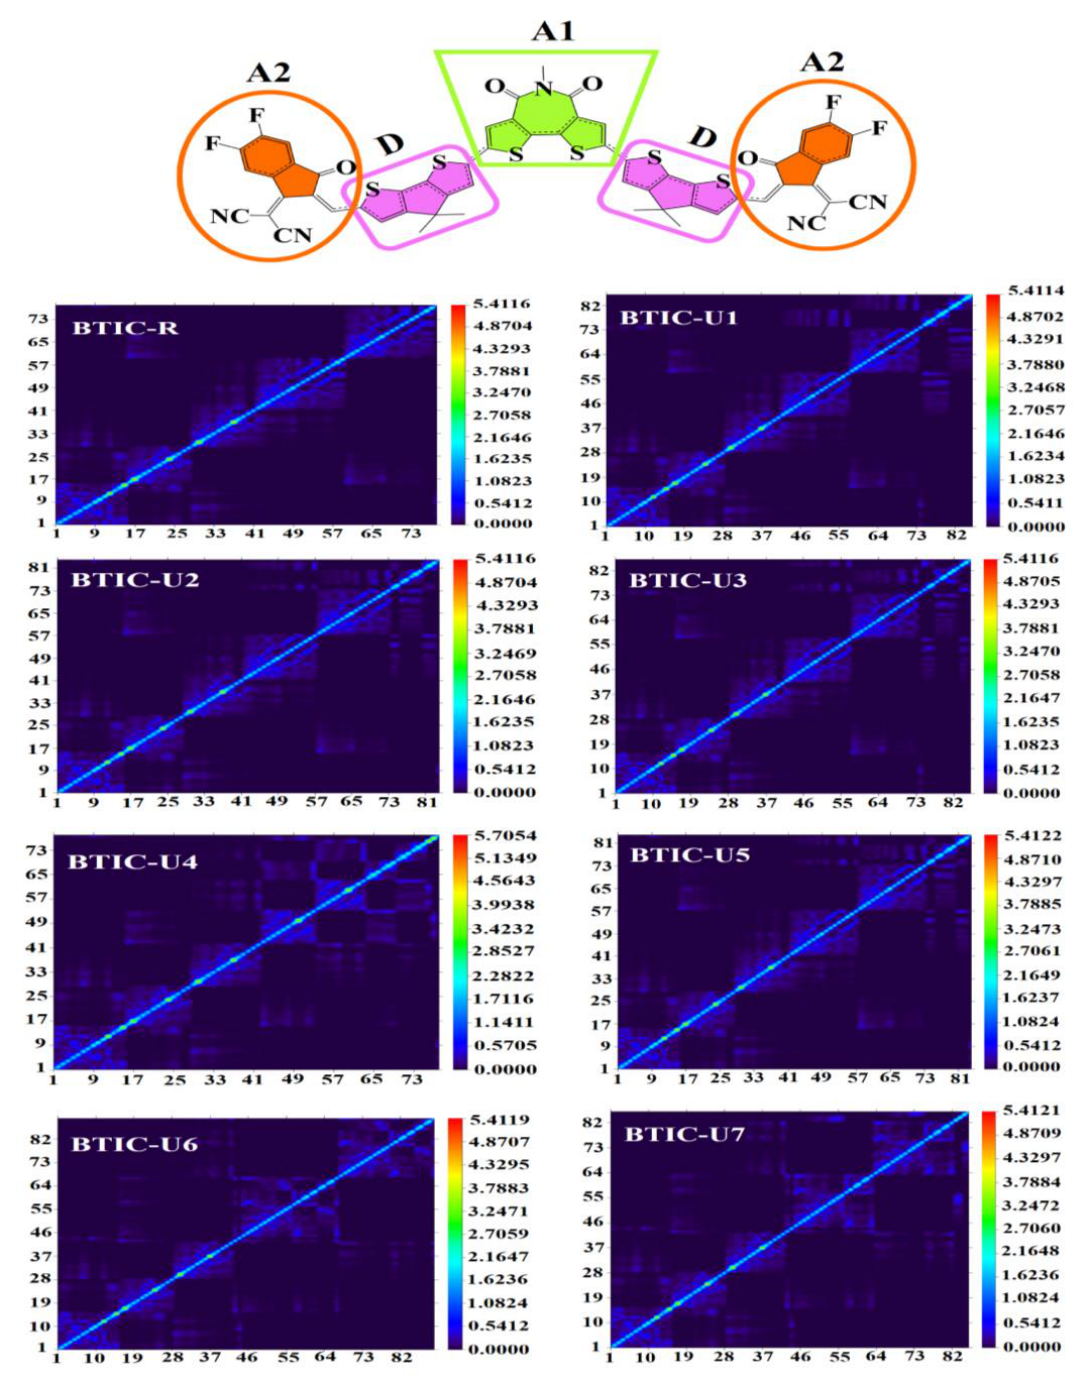
Figure 12. TDM plot of BTIC-R and BTIC-U1 to BTIC-U7 molecules.